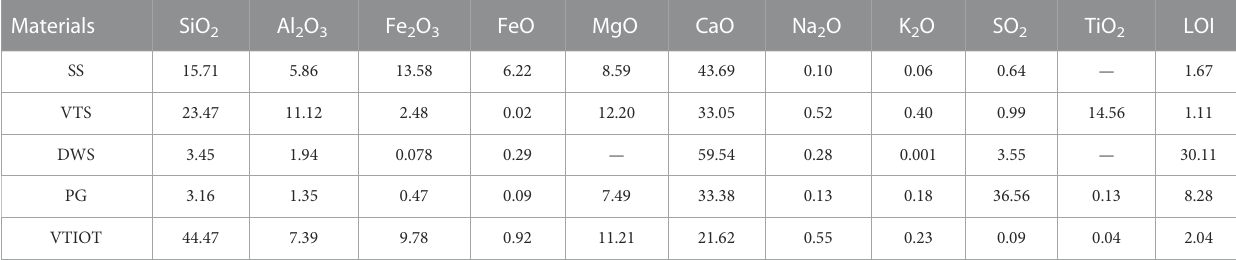
TABLE 1 Chemical composition of raw materials